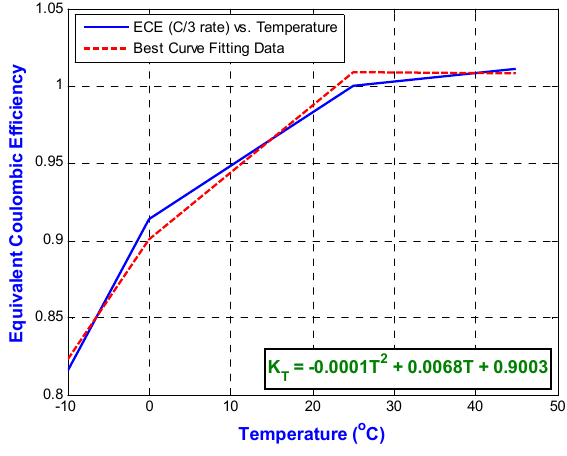
Figure 3. The influence of temperature on coulombic efficiency.